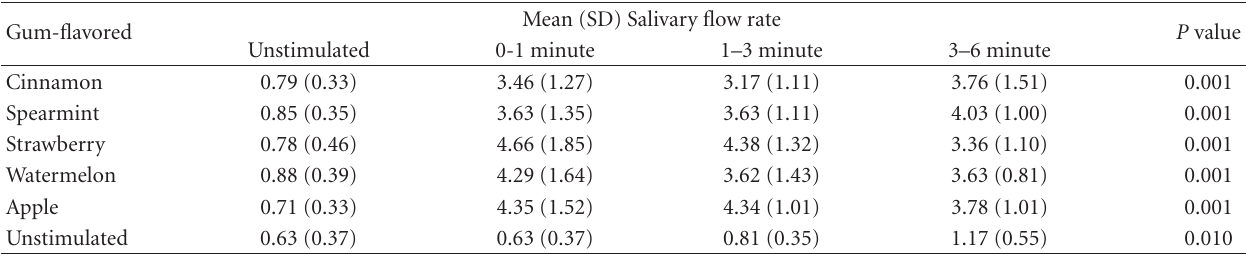
Table 1: The changes in mean salivary flow rate (SFR) over 6 min after the start of one pellet of cinnamon-, strawberry-, spearmint-, watermelon, or apple-flavored chewing gum compared with unstimulated SFR. The mean (SD) of SFR before and 0-1, 1–3 and 3–6 min after the start of di ff erent flavored chewing gums is shown (also see Figure 1).